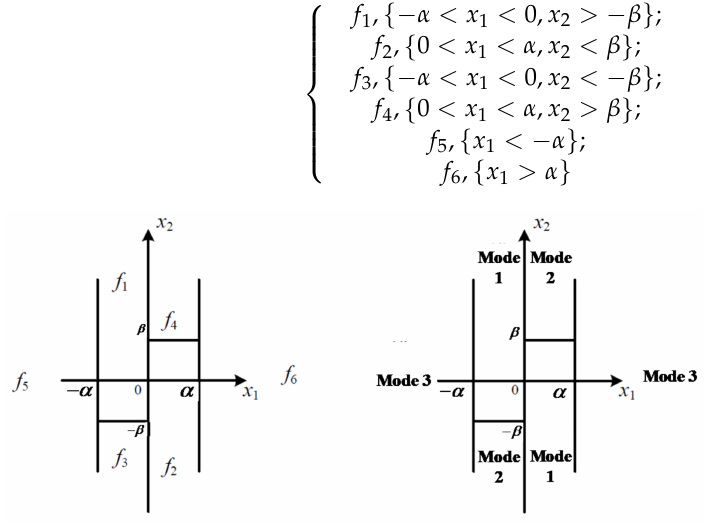
Figure 4. Multimode